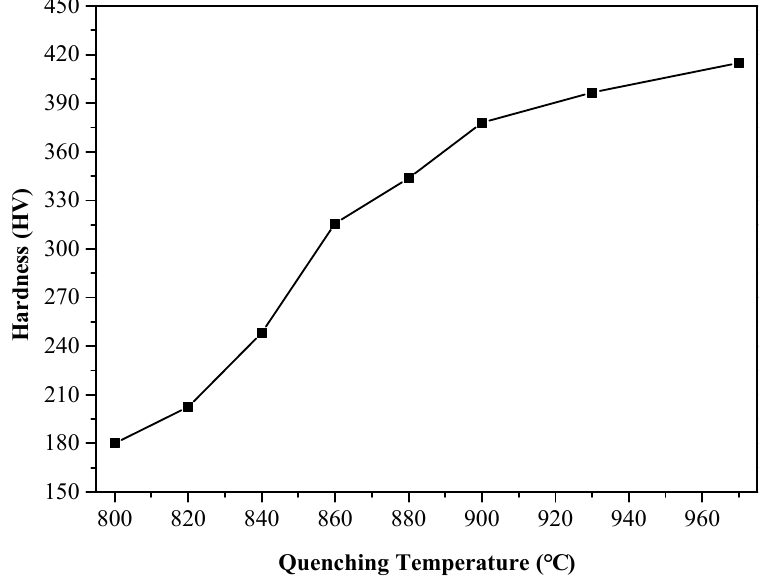
Figure 3. Variation of hardness with increase in quenching temperature.